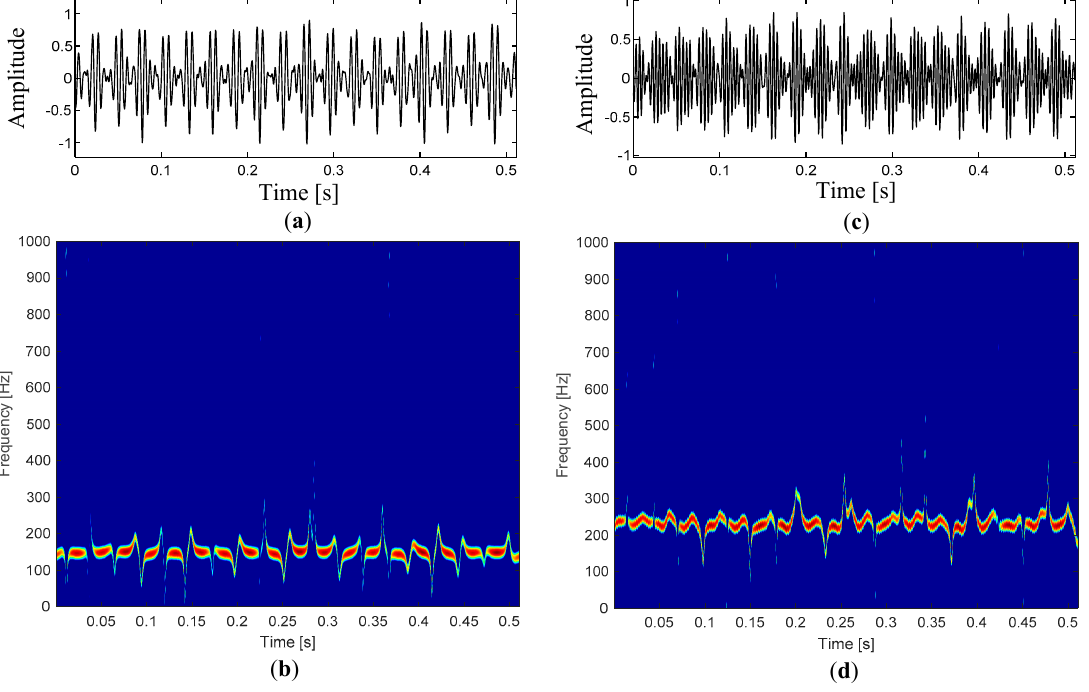
Figure 23. The time domain waveform of the displacement signal: ( a ) Time domain waveform of the wavelet subspace wp 4,3 ( n ) ; ( b ) IF curve of the wavelet subspace wp 4,3 ( n ) ; ( c ) Time domain waveform of the wavelet subspace wp 4,4 ( n ) ; ( d ) IF curve of the wavelet subspace wp 4,4 ( n )